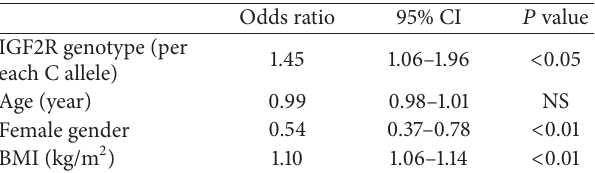
Table 3: Factors associated with diabetes from logistic regression analysis.